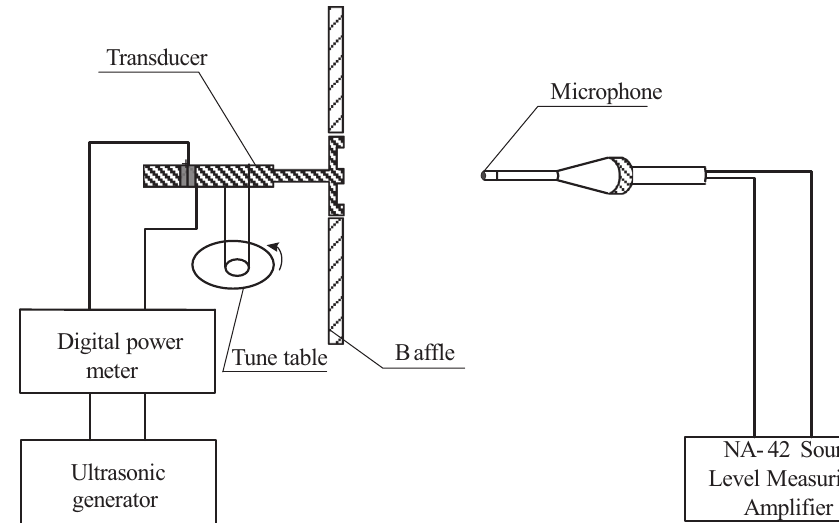
Figure 8. Experimental setup for the measurement of directivity pattern.